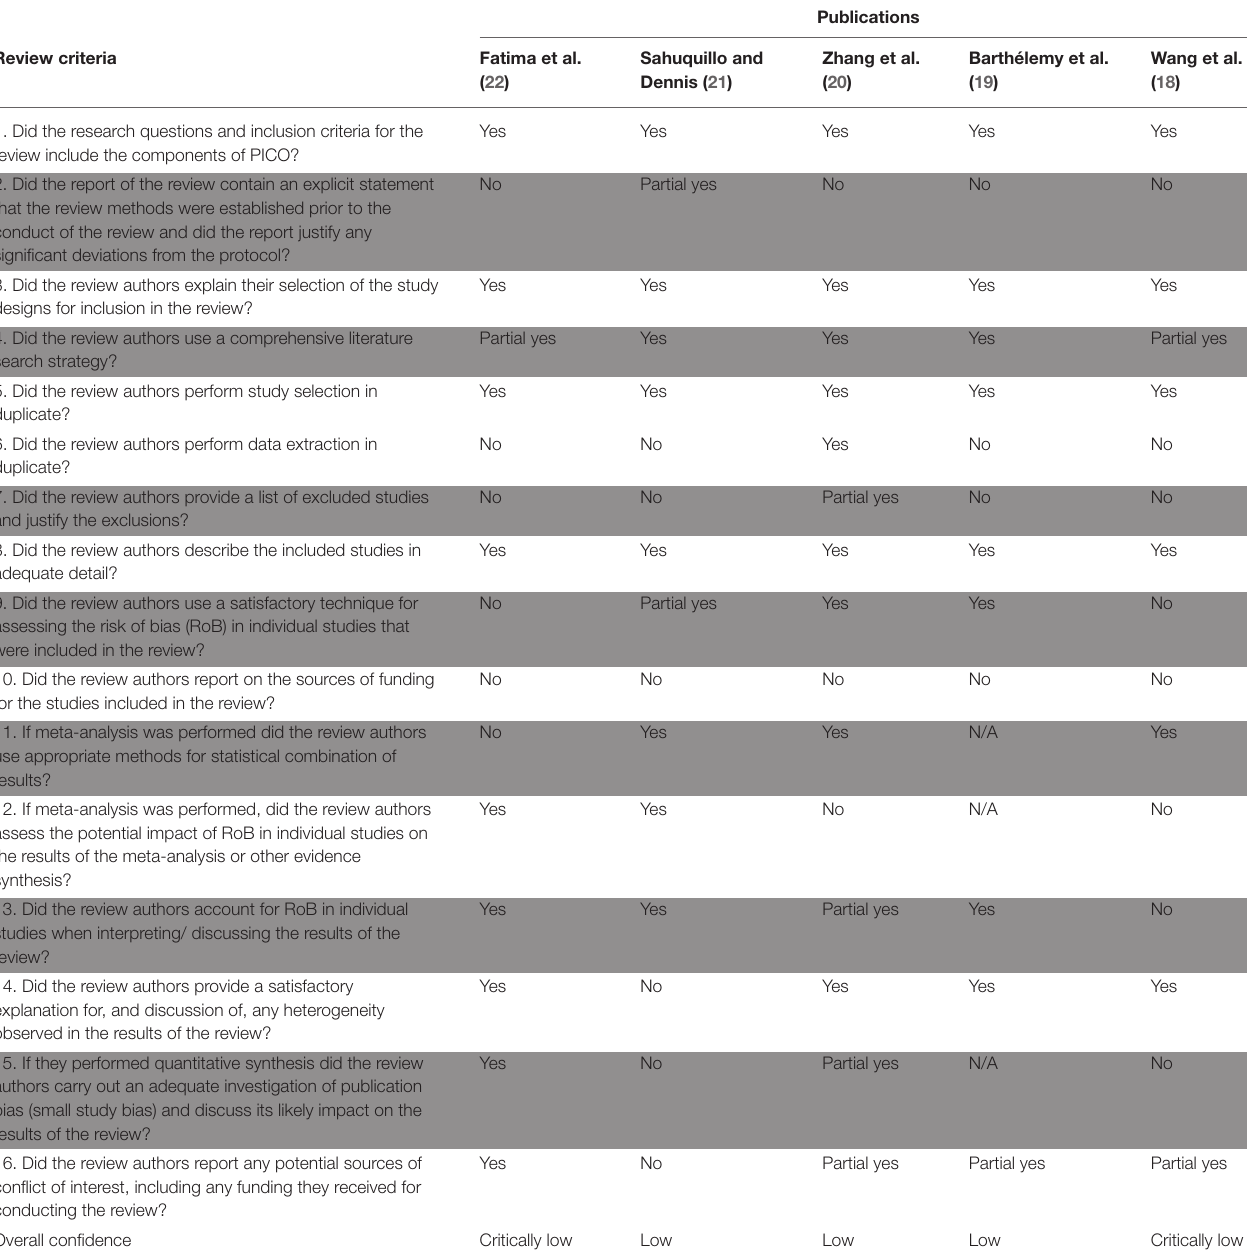
Shaded rows indicate critical domains. RoB, risk of